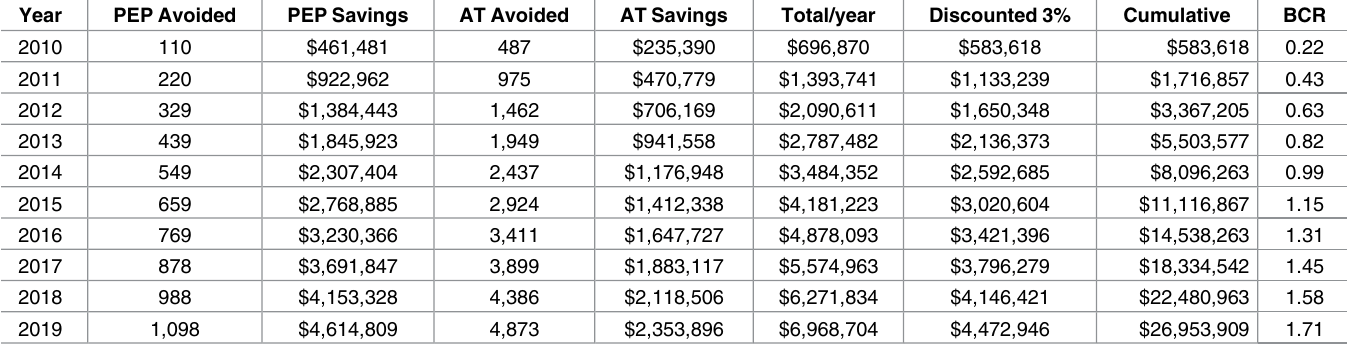
Table 4. Costs of the Long Island ORV program in 2008 dollars.